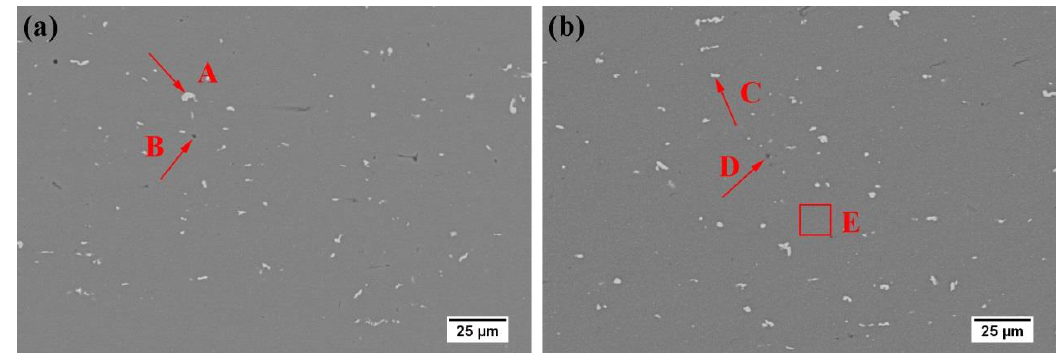
Figure 1. Scanning electron microscope (SEM) morphologies of alloy AA ( a ) and AZ ( b ) after solution treatment.